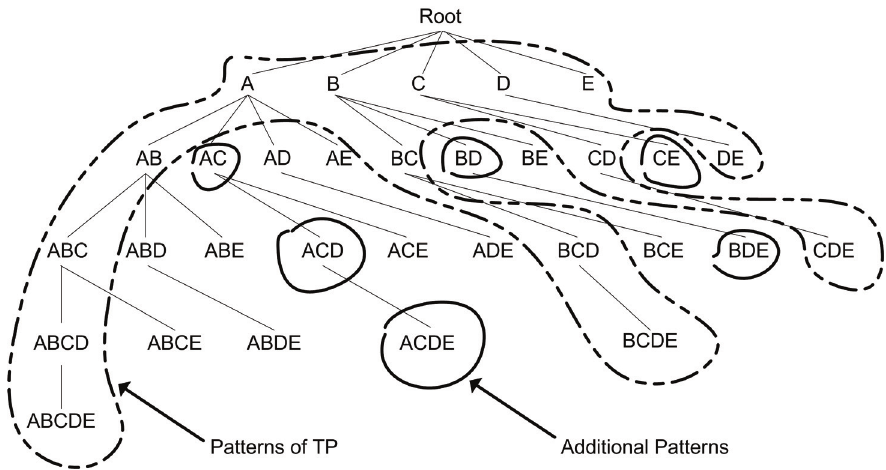
Fig. 1. Total search space for 5